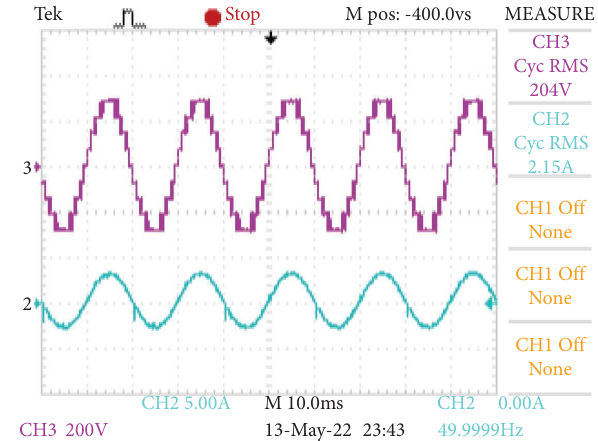
Figure 23: Output voltage and inductive load current for 9-level inverter.